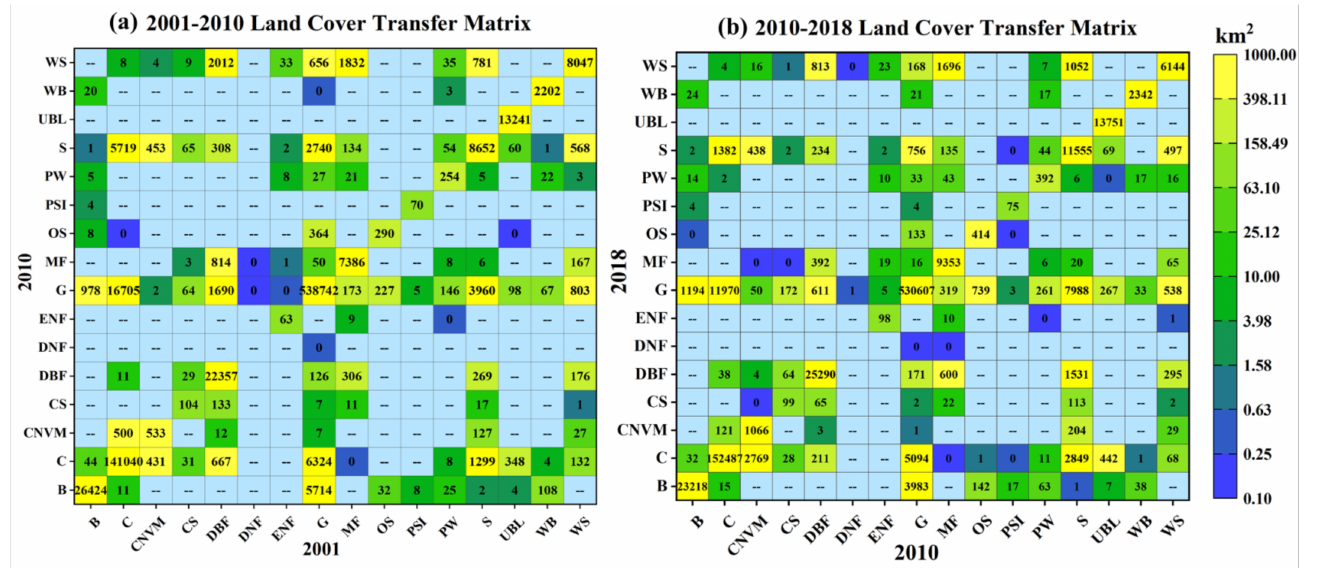
Figure 8. The land cover transfer matrix in the Yellow River Basin for 2001–2010 ( a ) and 2010–2018 ( b ).